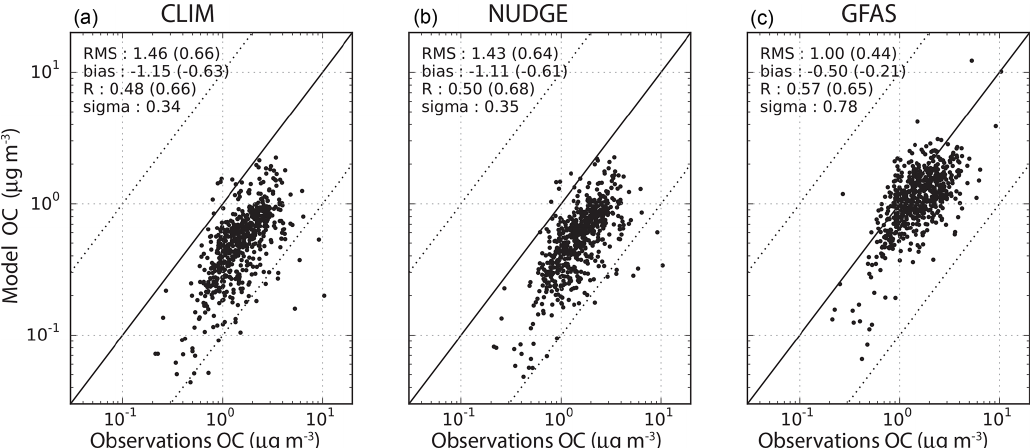
Figure 15. Scatterplot of observed surface concentrations of OC from the IMPROVE network and collocated simulated daily concentrations from the CLIM (a) , NUDGE (b) , and GFAS (c) simulations. The yearly mean is calculated from January 2003 to December 2004 for all available stations (see Fig. 2 for the location of the stations). The statistical parameters are calculated as in Fig.